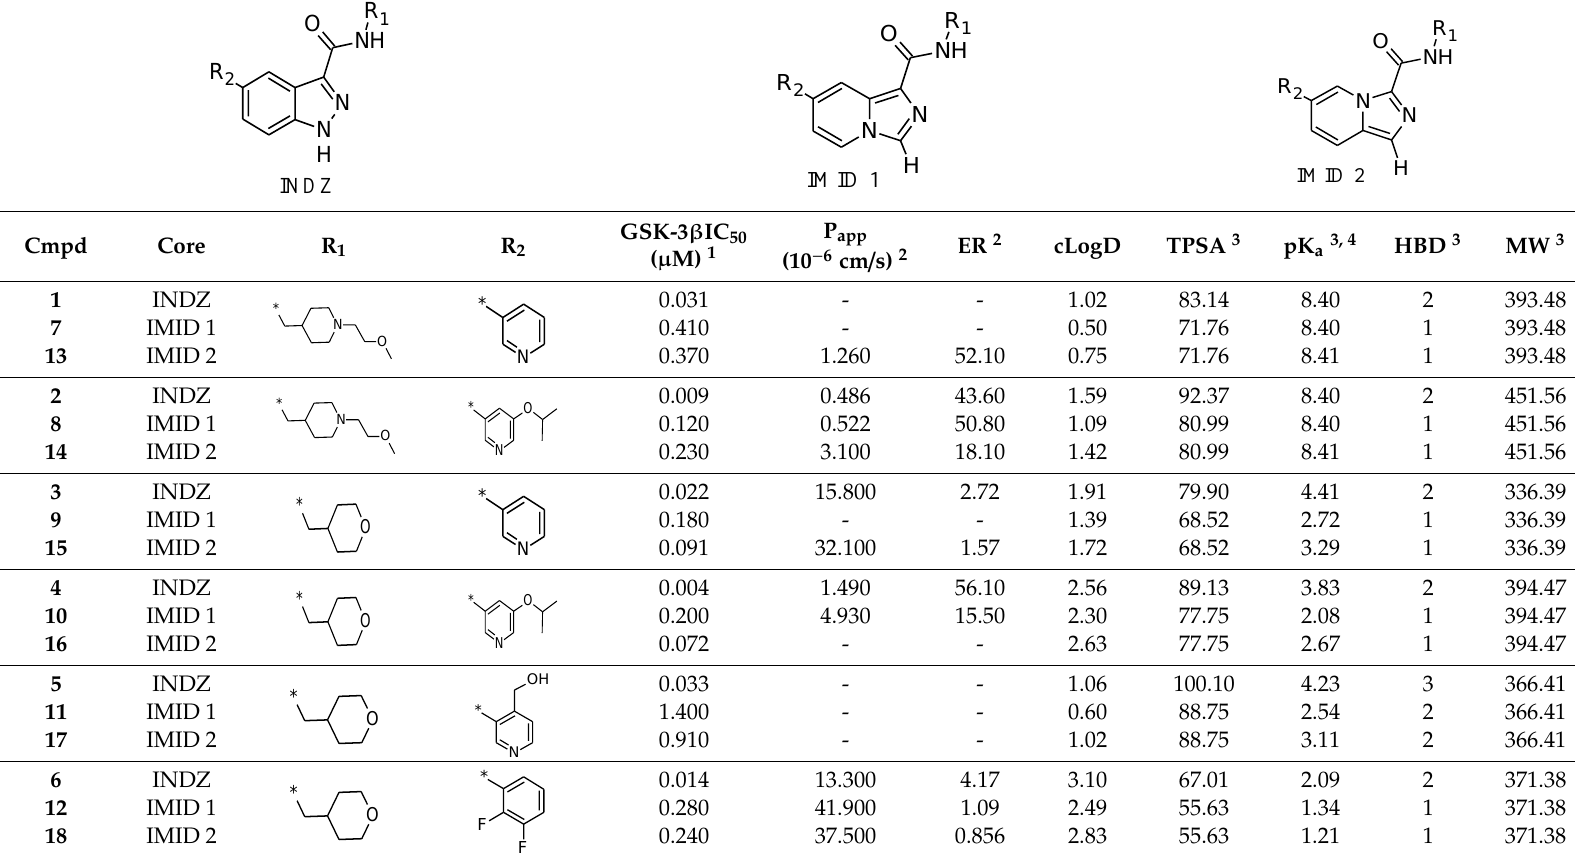
Table 1. SAR exploration of INDZ, IMID 1, and IMID 2 derivatives.